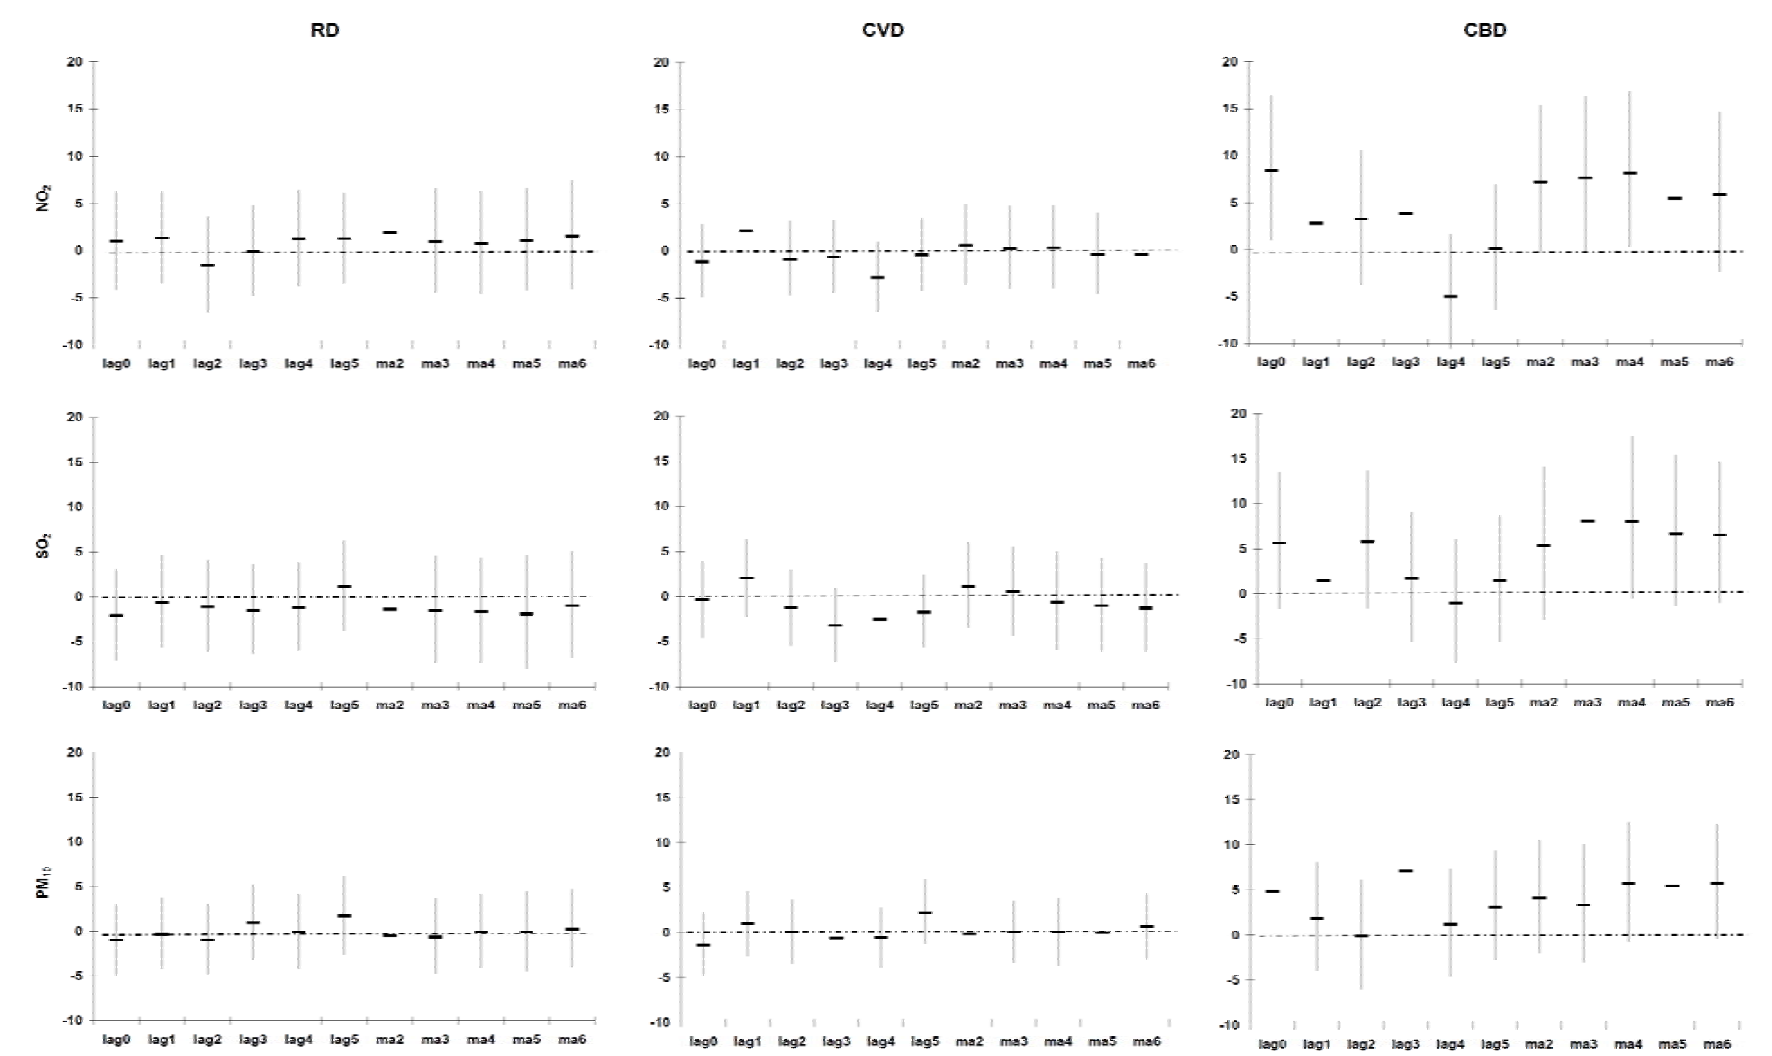
Figure A7. Percentage change (95% CI) in cause-specific mortality in Cape Town per inter-quartile range increase in PM during 2001–2006 (cold period), adjusted for Tapp, rainfall, wind speed and public